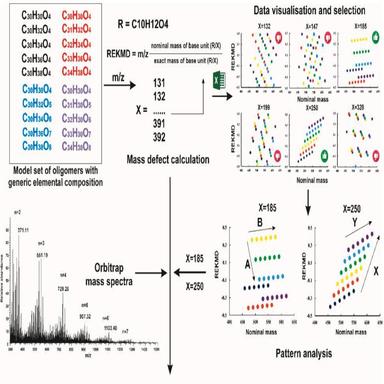
Generalized workflow for the development of REKMD approach to the discrimination of homologous series of lignin oligomers.